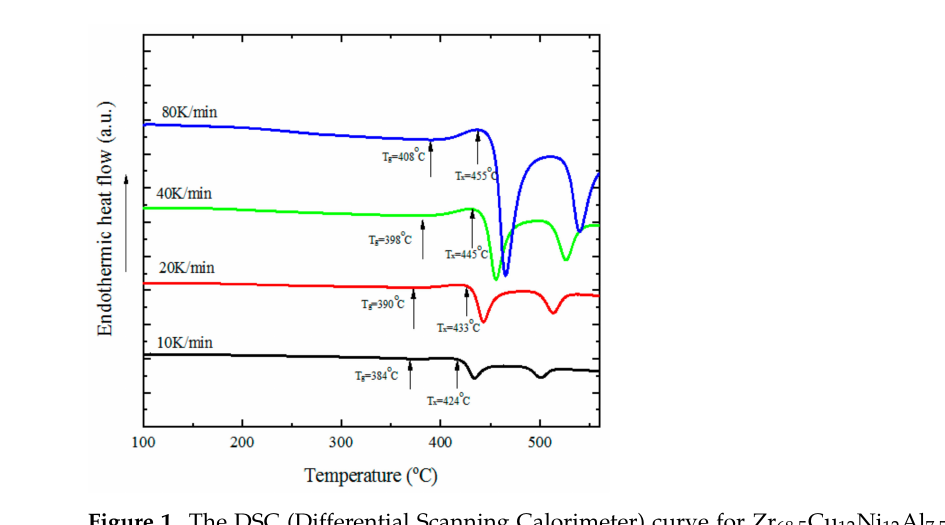
Figure 1. The DSC (Differential Scanning Calorimeter) curve for Zr 68.5 Cu 12 Ni 12 Al 7.5 at different heating rates.